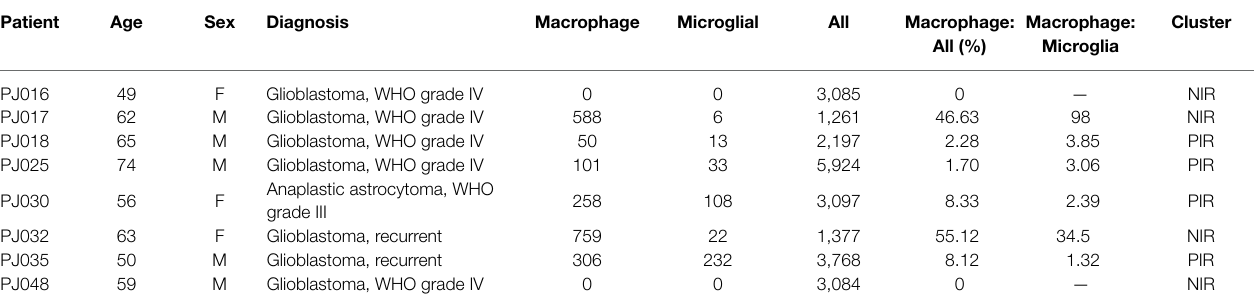
TABLE 2 | Summary of scRNA-seq